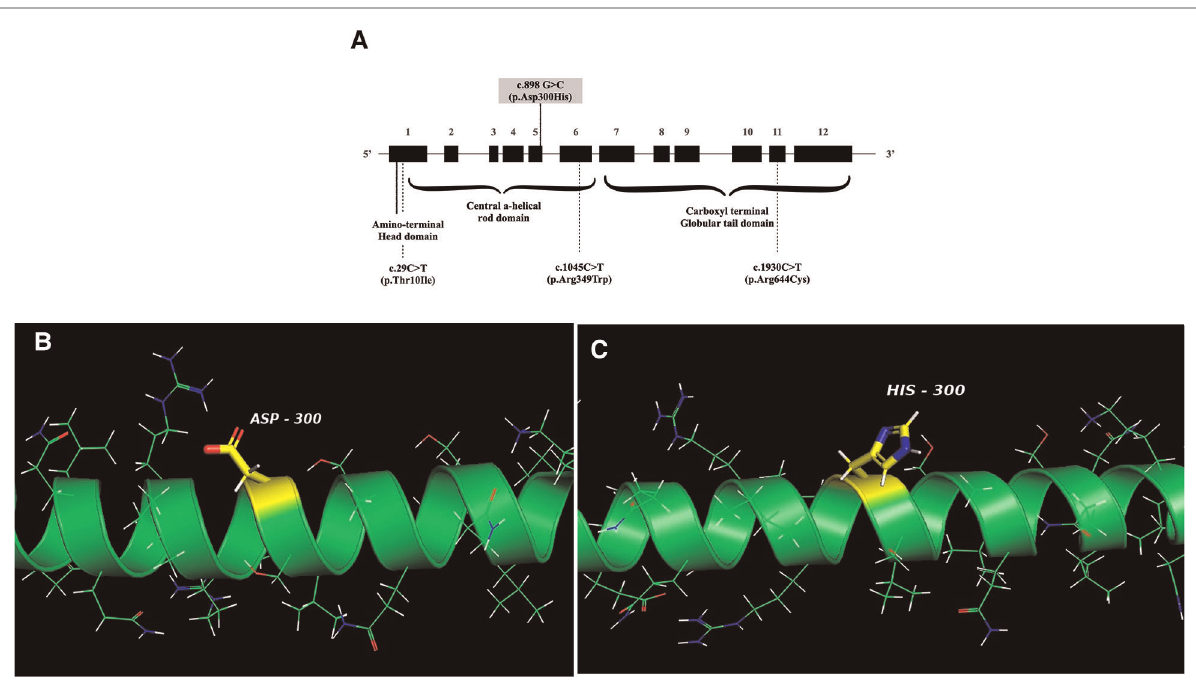
FIGURE 3 ( A ) Schematic structure of the LMNA gene. The mutation of the patient is indicated with a solid line, and the locations of mutations associated with FSGS are shown in dotted lines. FSGS: focal segmental glomerular sclerosis. ( B , C ) The crystal structure of wild-type human lamin A coil 2B domain and a model of proposed p .Asp300His mutant. I-TASSER software and PyMol were used to model the wild-type human lamin A and the p .Asp300His mutant. The peptide chain of the human lamin A coil 2B domain (aa. 290 – 310 from left to right) is shown as an alpha-helical structure (green). Side chains are shown as sticks. The carbon atoms in the mutation site are highlighted in yellow and other carbons are in green. Nitrogen atoms are labeled blue, oxygen atoms are red, hydrogen atoms are white, and sulfur atoms are shown